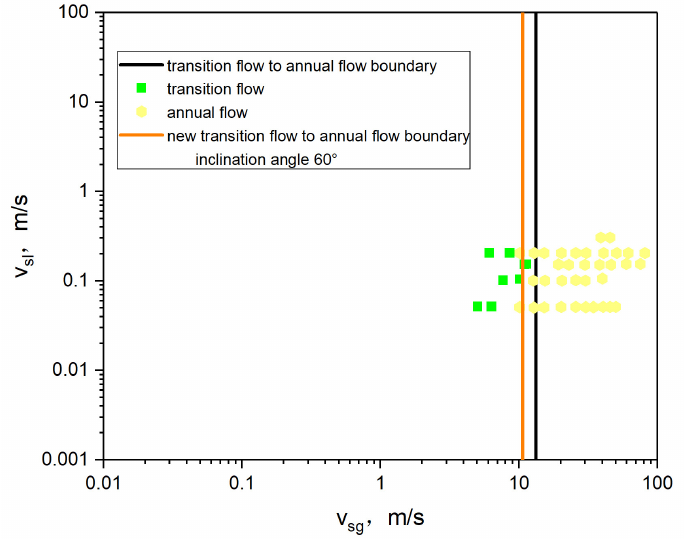
Figure 8. The boundary for discrimination of the transition from agitated flow to annular flow.